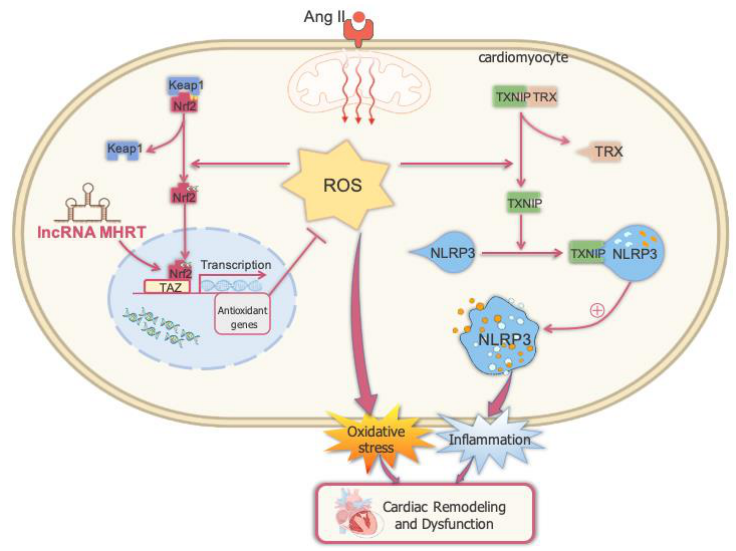
Figure 7. Overexpression of MHRT may inhibit Ang II-induced cardiomyocyte damage by activating Nrf2 .